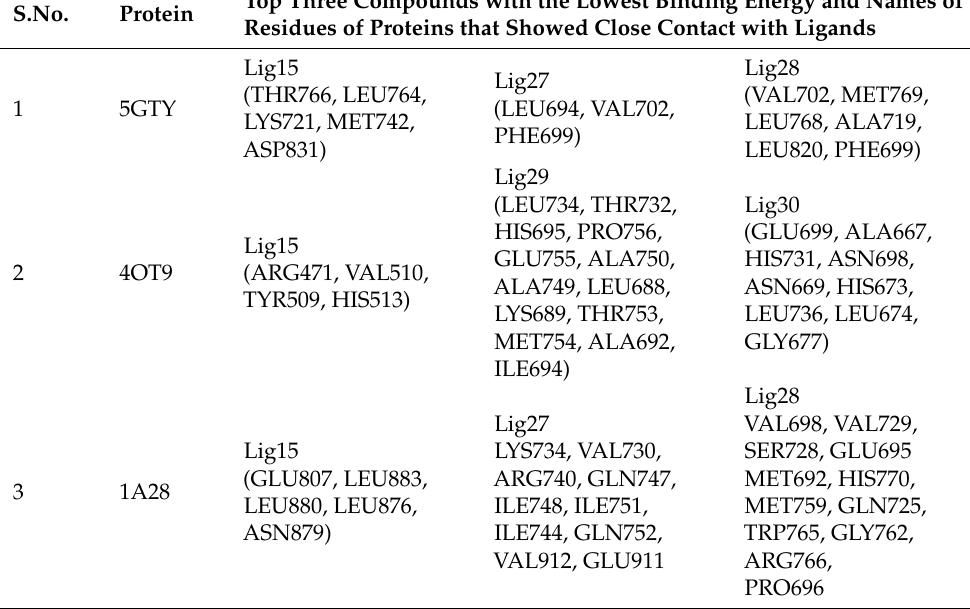
Table 5. Residues involved in the interaction of three best fit ligands with target proteins. Top Three Compounds with the Lowest Binding Energy and Names of S.No. Protein Residues of Proteins that Showed Close Contact with